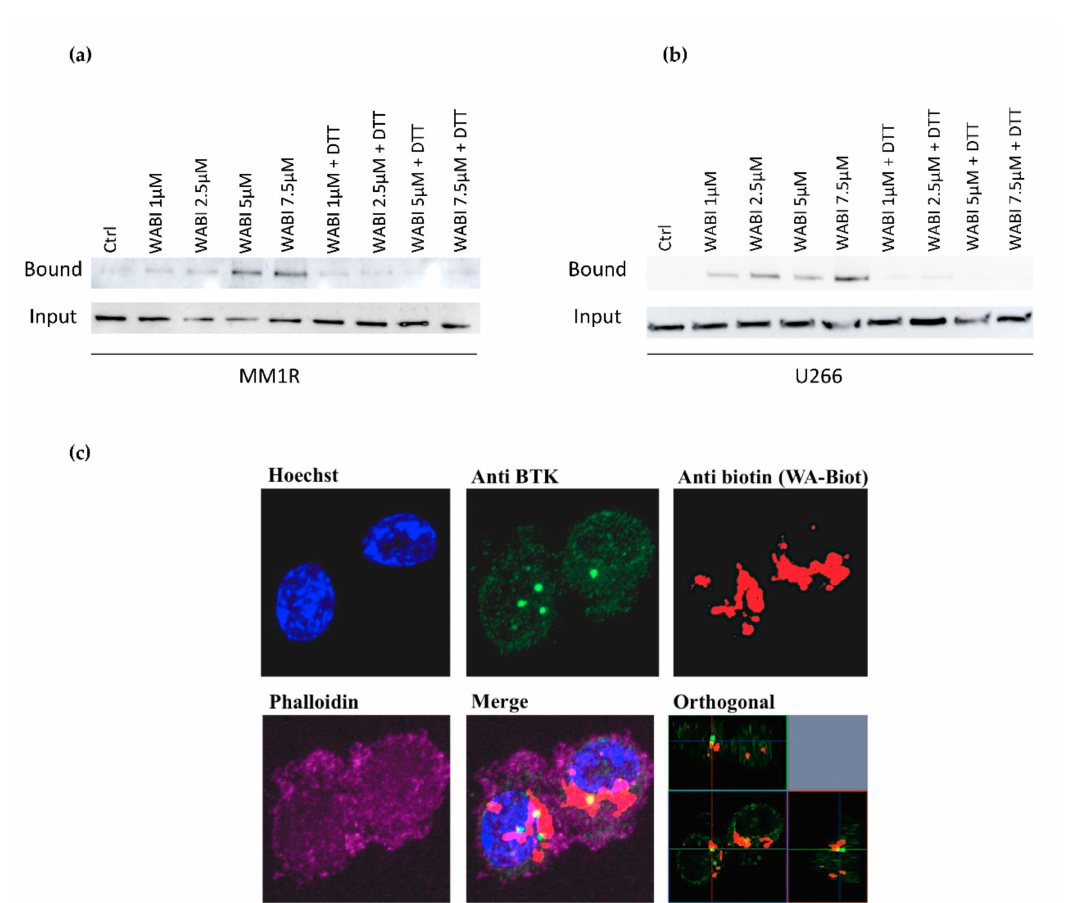
Figure 4. ( a ) Western immunoblot detection of BTK levels before and after pulldown with biotinylated WA (WABI), following 2 h WABI treatment in MM1R in the presence or absence of excess thiol donor DTT (1 mM). ( b ) Western immunoblot detection of BTK levels before and after pulldown with biotinylated WA (WABI), following 2 h WABI treatment in U266 cells in the presence or absence of excess thiol donor DTT (1 mM). ( c ) Confocal imaging of colocalization of BTK expression and WABI localization in MM1R